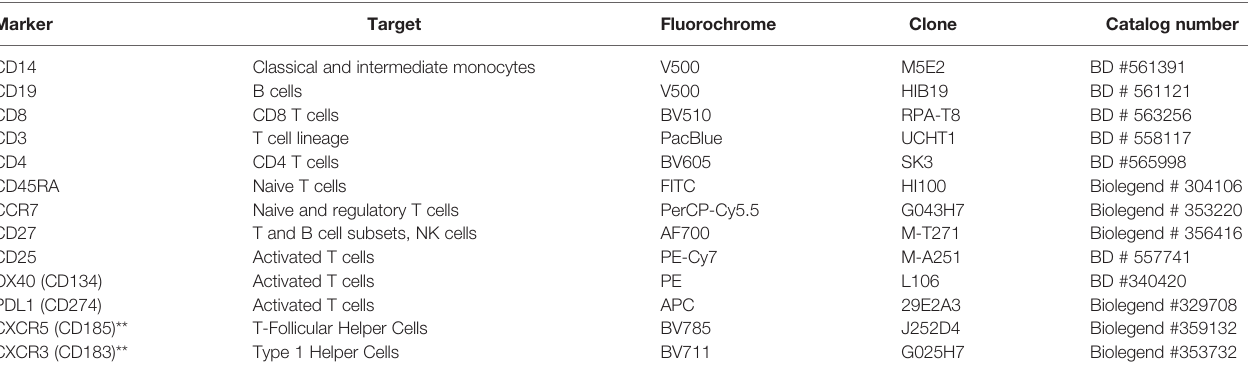
TABLE 6 | Antibody panel for in vitro T cell mediated immune responses to hepatitis B.